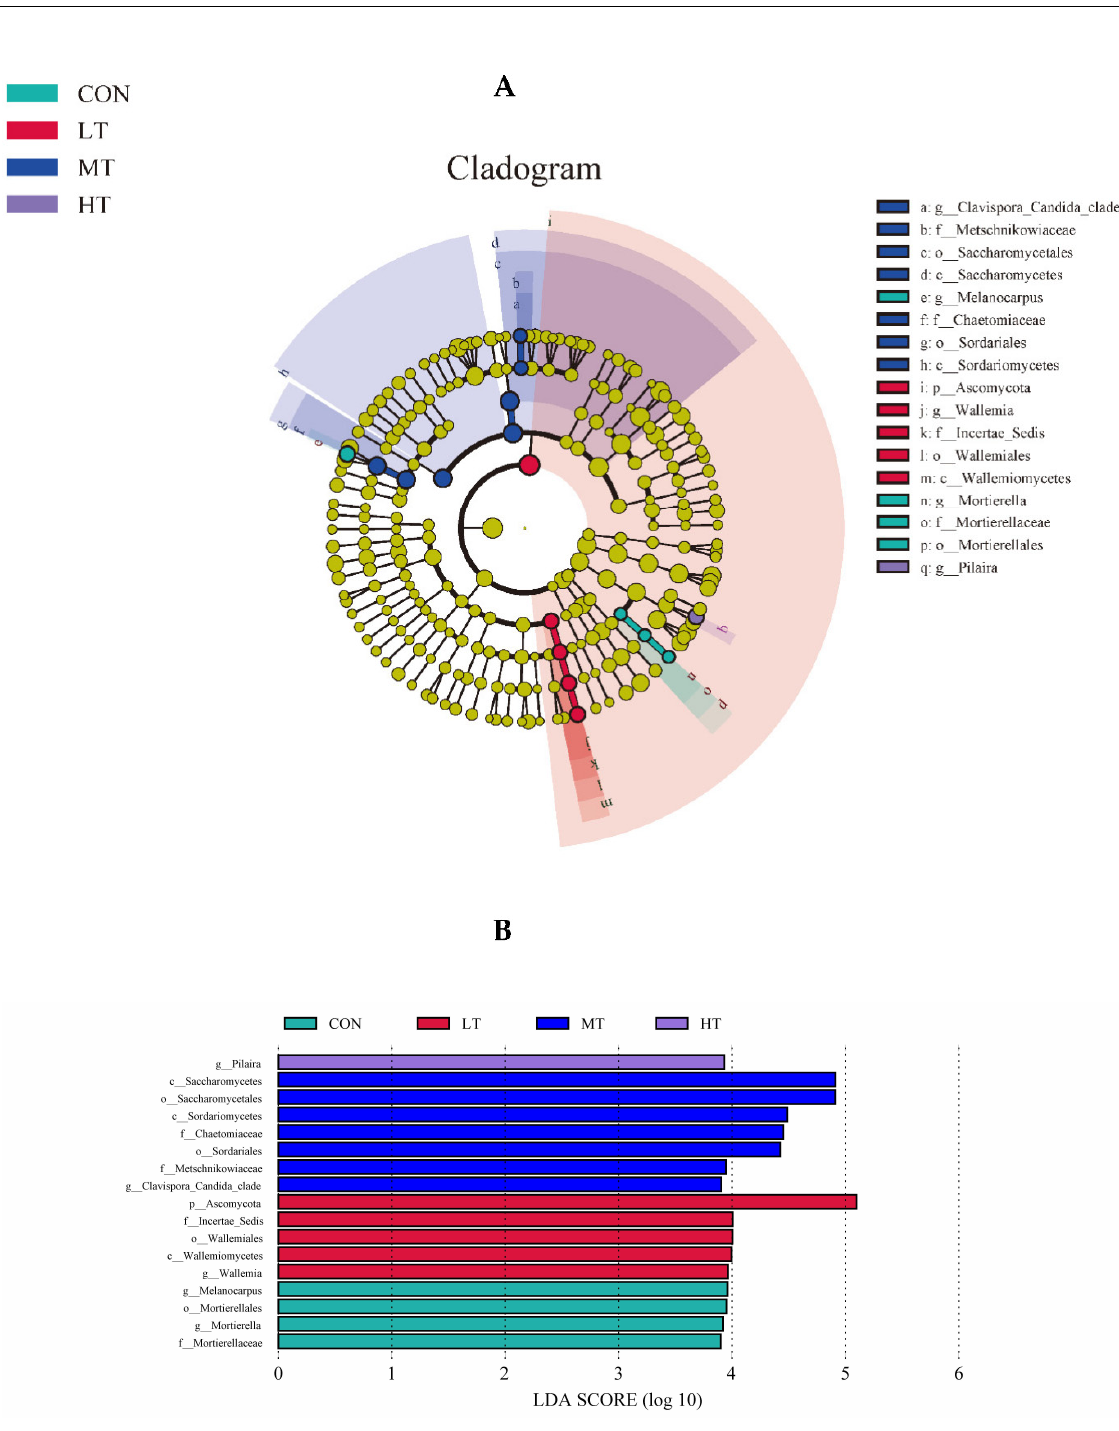
Figure 5. ( A ) LEfSe (linear discriminant analysis Effect Size) cladogram comparing fungal commu- nities among the four groups. ( B ) Histogram of LDA score calculated for each taxon ranging from phylum to genus among the four groups.